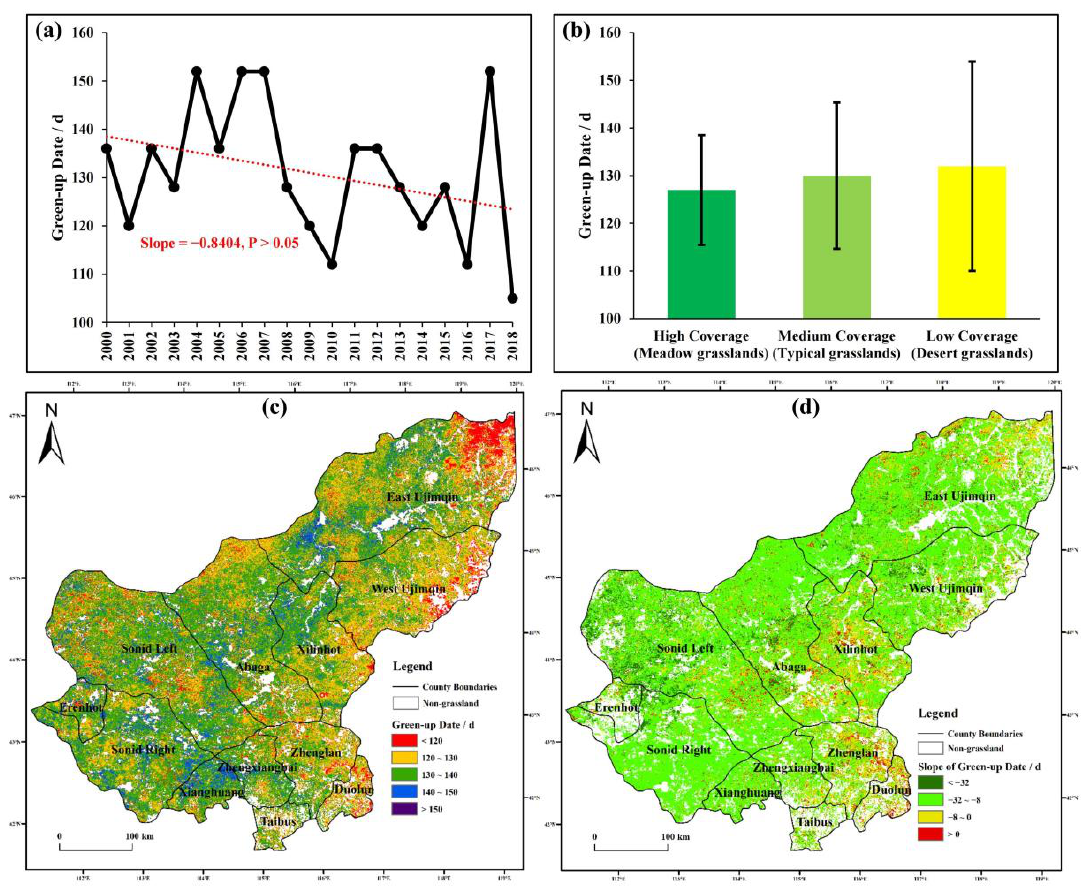
Figure 3. ( a ) Temporal variations of green-up date; ( b ) green-up date of different grassland types; ( c ) spatial variations and ( d ) the changing slope of green-up date in Xilin Gol grassland from 2000 to